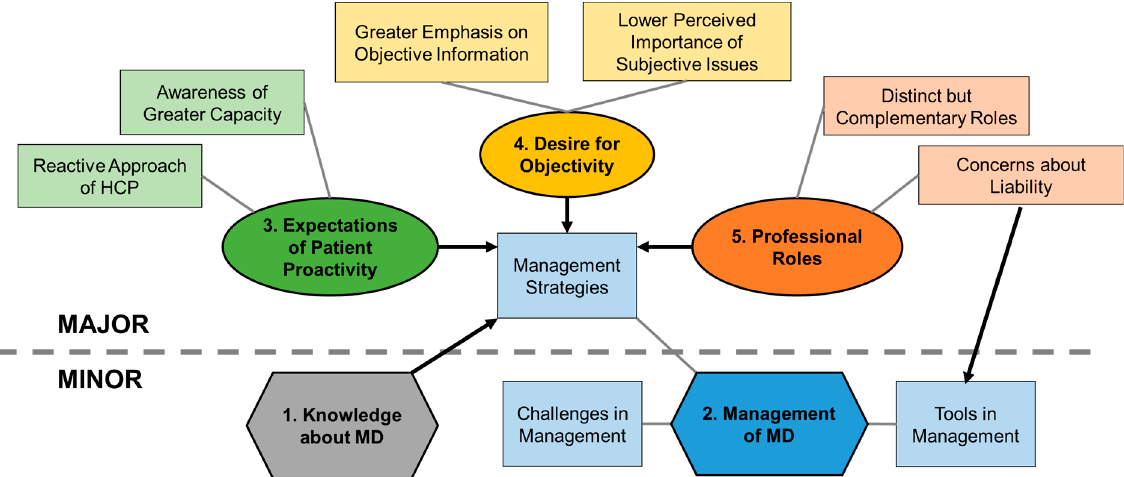
Figure 2. Thematic map of five themes derived from the thematic analysis. Major themes reflecting attitudes in MD management are represented by ovals. Minor themes describing knowledge and practices in MD management are represented by hexagons. Subthemes are represented by rectangles and connected to main themes by plain lines. Relationships between themes are represented by arrows. Table 2. Minor theme of knowledge about medication dysphagia and corresponding exemplar quotes.